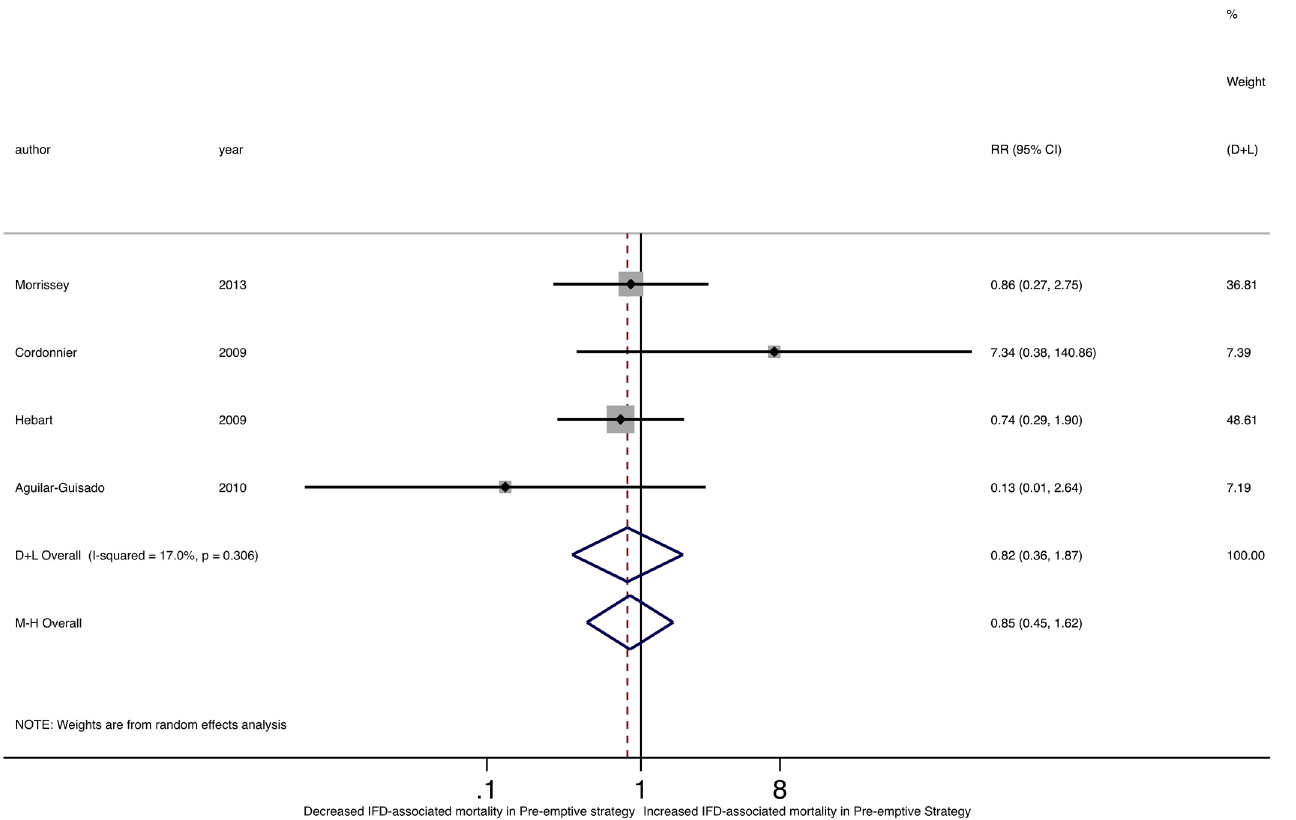
Fig 6. Forest plot of pooled relative risk of IFD-associated mortality comparing pre-emptive to empirical strategies.